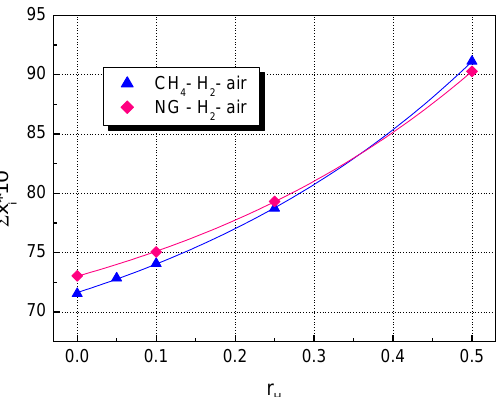
Figure 10. Influence of hydrogen fraction, r H , on the sum of peak mass fractions from radical species, H 2 -blended fuels; flames of stoichiometric mixtures at ambient p 0 and T 0 .